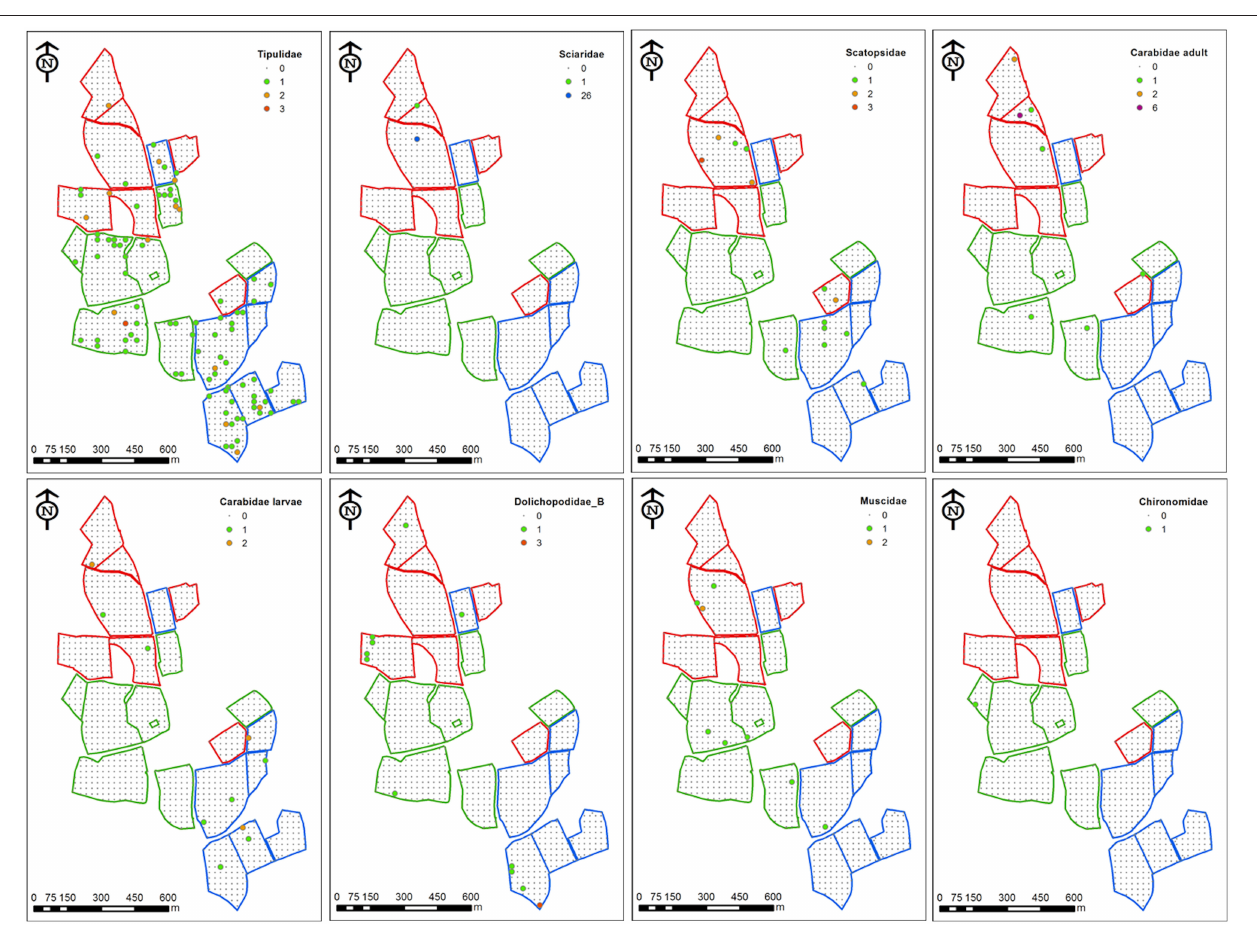
FIGURE 1 | Distribution maps for selected key taxa on the North Wyke Farm Platform in 2012. Individual soil cores were taken (1130 in total) across 19 fields in three farms (red boundaries = Farm 1, green = Farm 2 and blue = Farm 3). Large circles represent sampling points containing individuals, colored by abundance (see individual